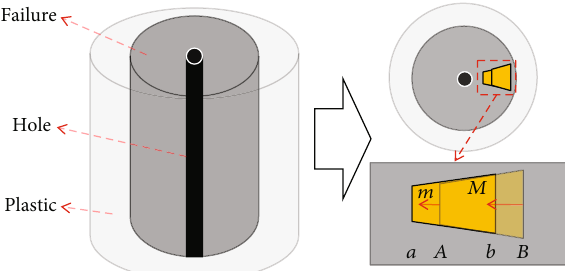
Figure 6: Radial line strain of the microelement around the